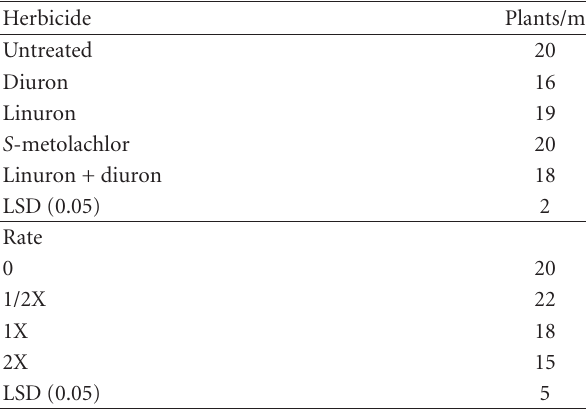
Table 2: Sesame stand response to preemergence herbicides and herbicide rate at Lorenzo in 2008 a